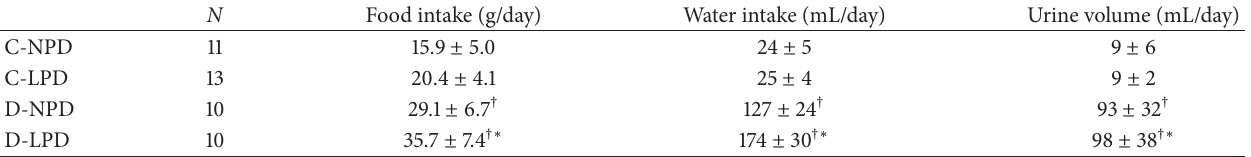
Table 1: Mean daily food intake, water intake and urine volume for one rat during the whole period after dietary intervention. N Food intake (g/day) Water intake (mL/day)